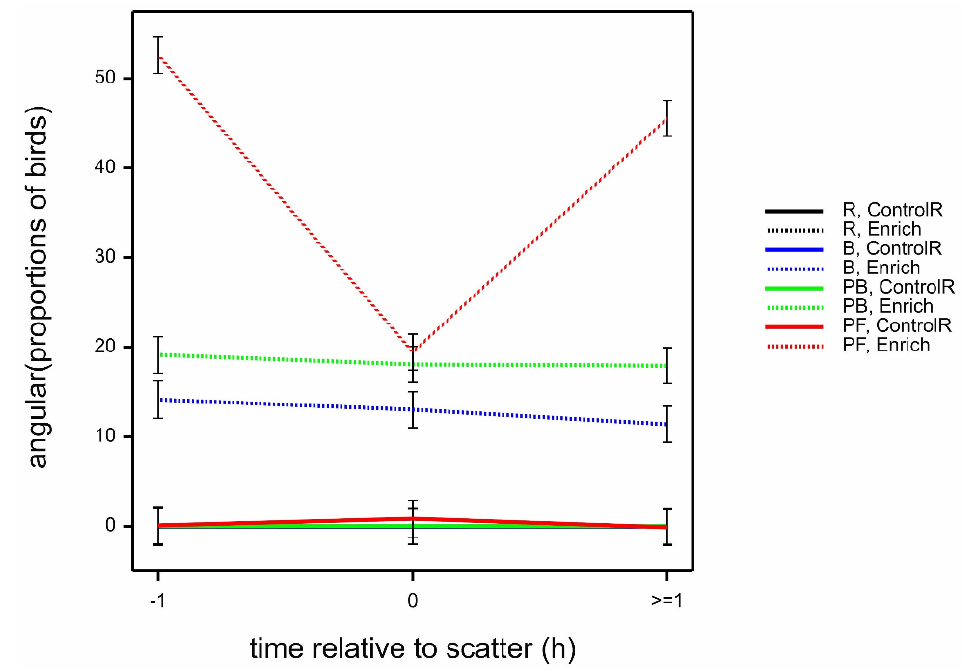
Figure 5. Mean ± SE angular (proportions of birds) observed at, but not interacting with, enrichments in Enrich and Control R locations, according to treatment (R, B, PB, PF) and time relative to scatter ( − 1, 0, ≥ 1), estimated from LMM. (Note that estimates are all 0 for R, Enrich and for R, B and PB at ControlR).